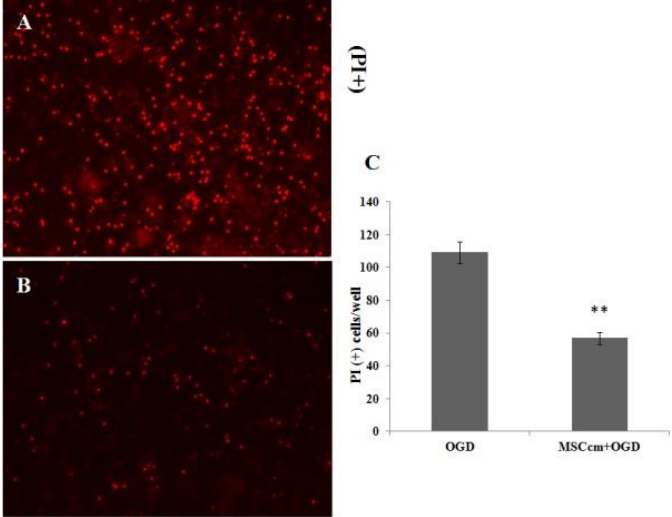
Figure 3. BM-MSC conditioned medium protected spinal cord neuron–glial cultures from OGD-induced damage. ( A ) OGD-induced neuron–glial cultures. ( B ) OGD-induced and MSCcm-treated neuron–glial cultures. ( C ) Quantification of propidium iodide (PI) positive cells of A and B. The results are reported as mean ± SEM. ** p < 0.01 indicates significant difference between saline + OGD and MSCcm + OGD treatment.